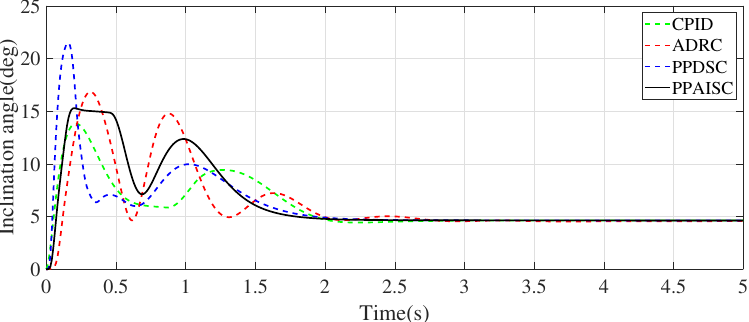
Figure 5. Time responses of inclination angle sin − 1 ( (cid:107) ϕ 1 (cid:107) ) under difference controllers.